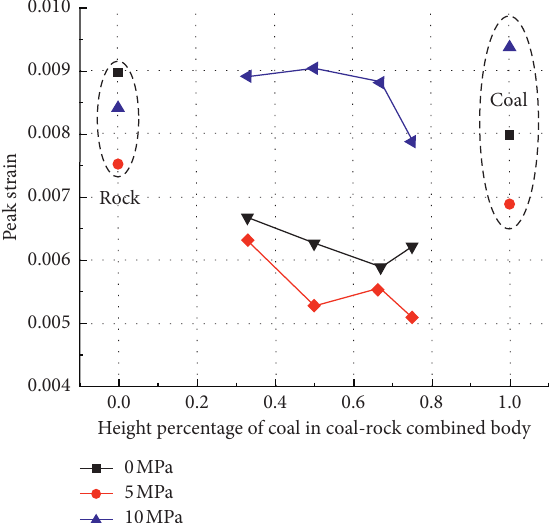
Figure 8: Relationship between peak strain and value of coal-rock combination under different confining pressures. Figure 9: Relationship between elastic modulus and δ value of coal-rock combination under different confining